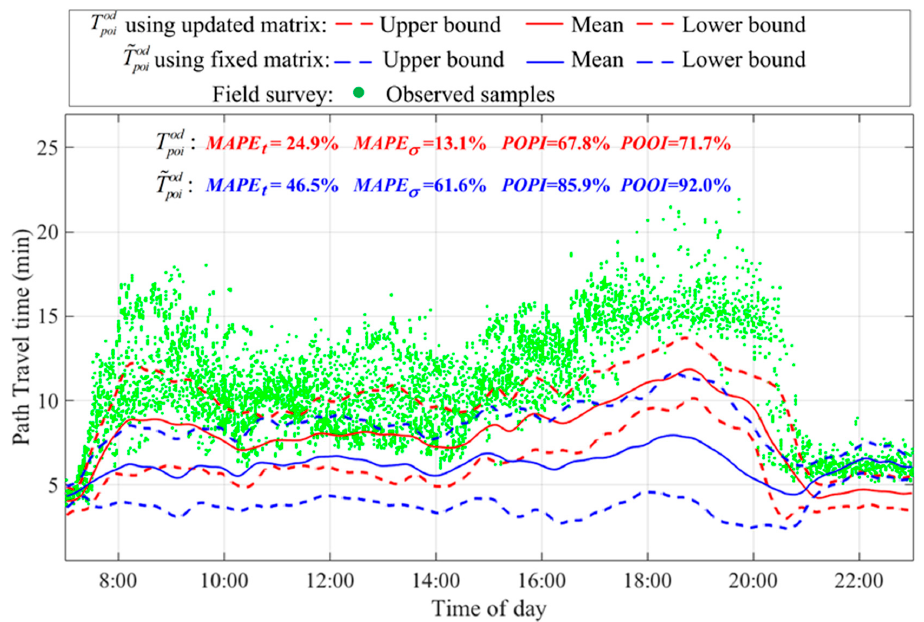
Figure 7. Path travel time distributions estimated from point detector data by using updated and fixed spatial